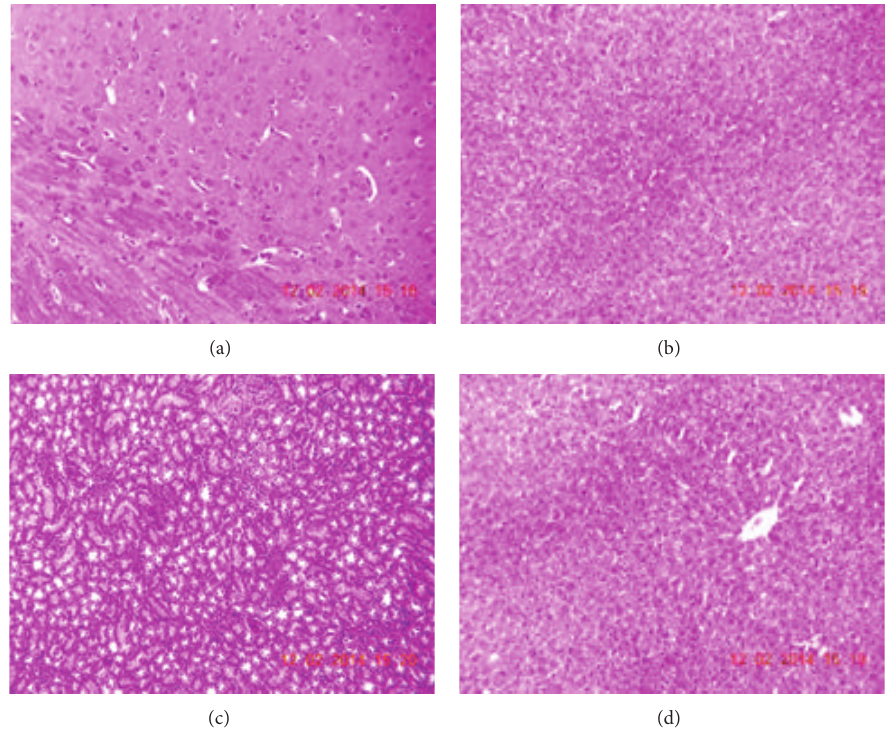
Figure 9: Photomicrograph of (a) brain, (b) heart, (c) kidney, and (d) liver of group treated with blank